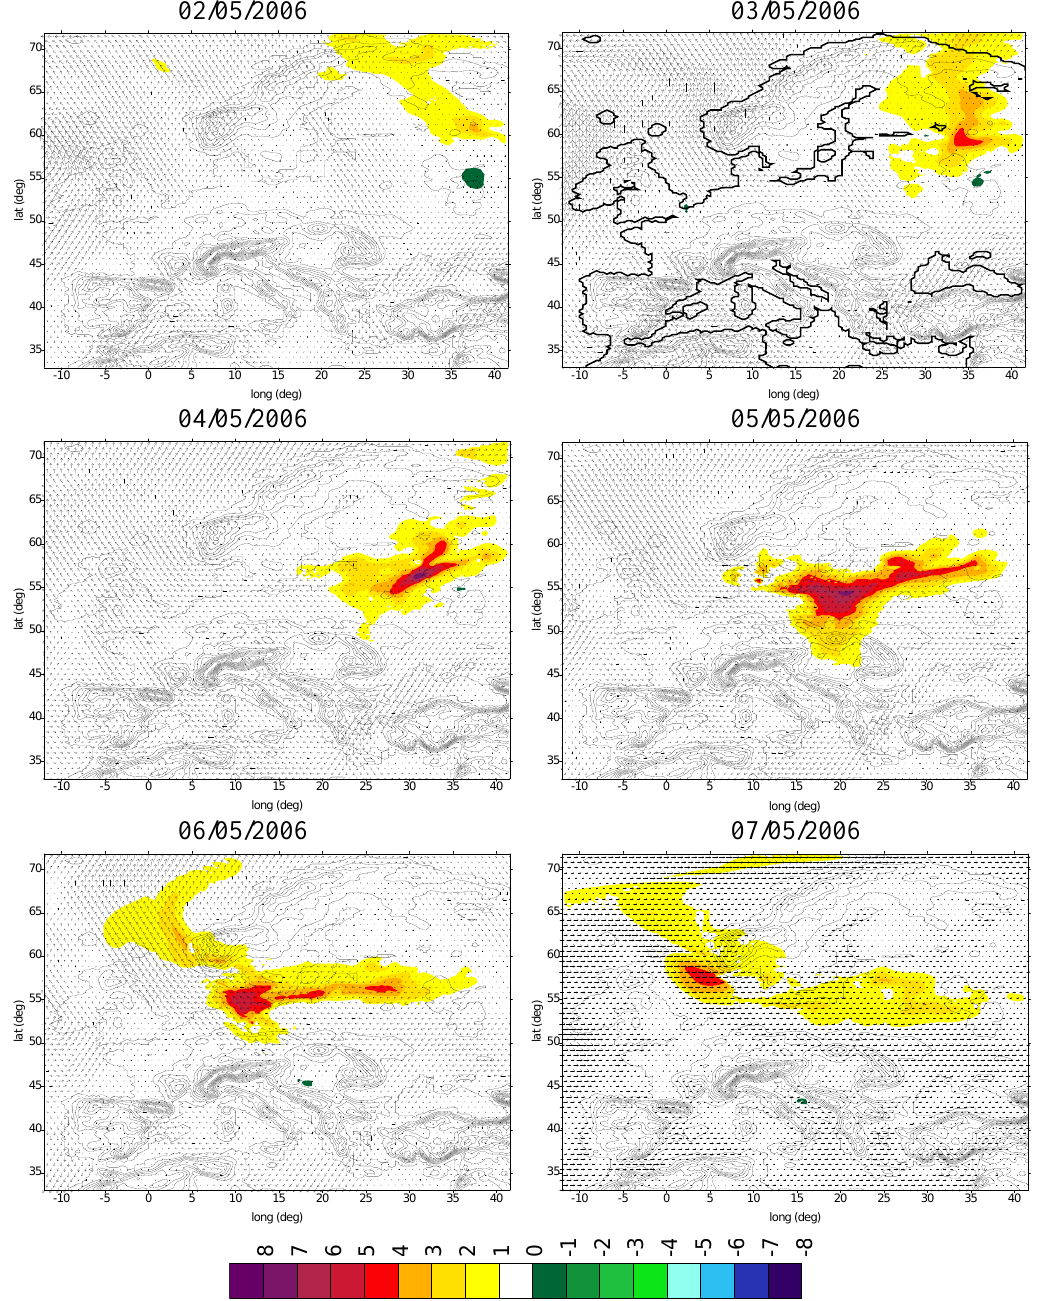
Fig. 11. Synergistic effect of biomass burning and biogenic emissions on maximum hourly surface O 3 (ppb) during the period 2–7 May 2006. The wind flow at 12:00UTC is